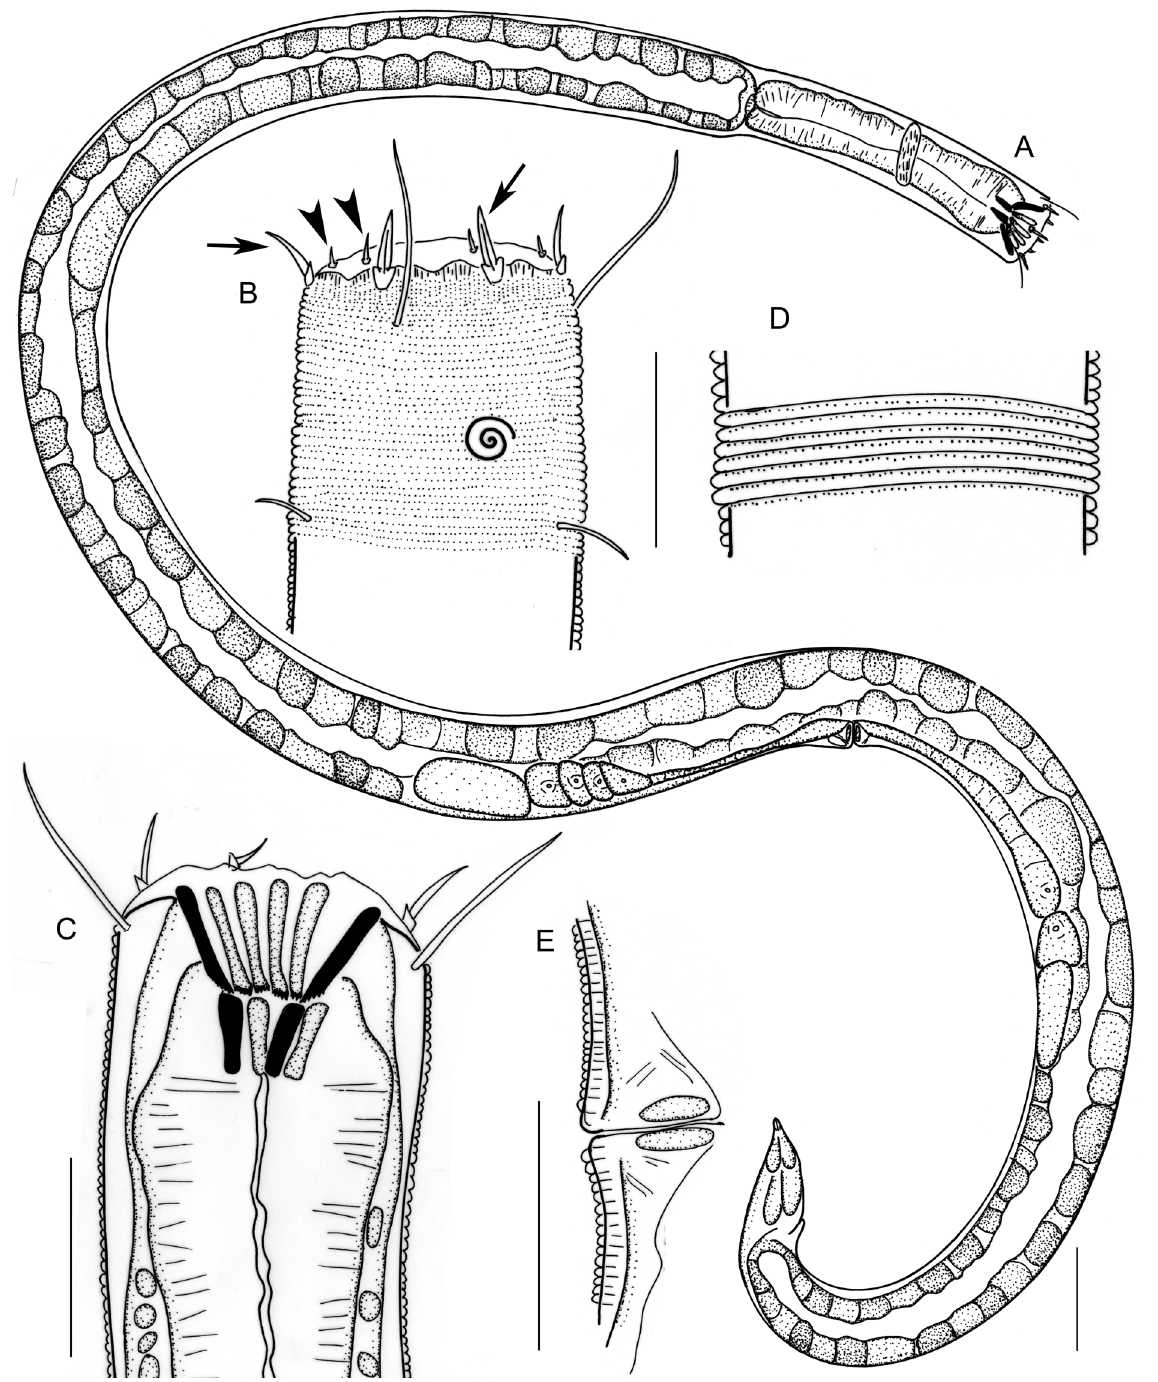
Fig. 2. Gammanema magnum sp. nov., paratype, ♀. A . Overview, showing the slender body shape, the cylindrical pharynx with anterior swollen portion , the two reflexed ovaries, the caudal glands with spinneret, and the conical tail. B . Surface view of head, showing the very small multispiral amphideal fovea, leaf-like inner (arrowheads) and outer (arrows) labial setae, four slender cephalic and four slender cervical setae, and the transverse rows of punctuations. C . Inside view of head, showing similar features as the male holotype. D . Cuticle with transverse rows of punctuations. E . Vulva. Scale bars: A = 100 μm, B–E = 50